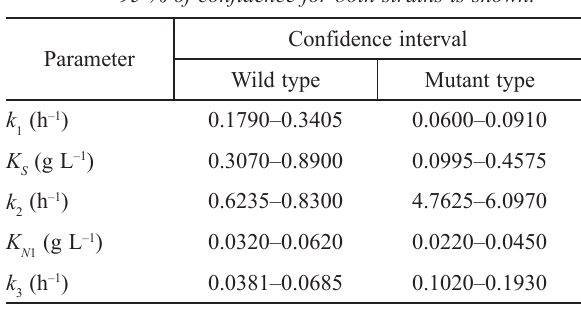
Table 2 – The confidence interval for each parameter. After 1000 weighted bootstrap, confidence interval with 95 % of confidence for both strains is